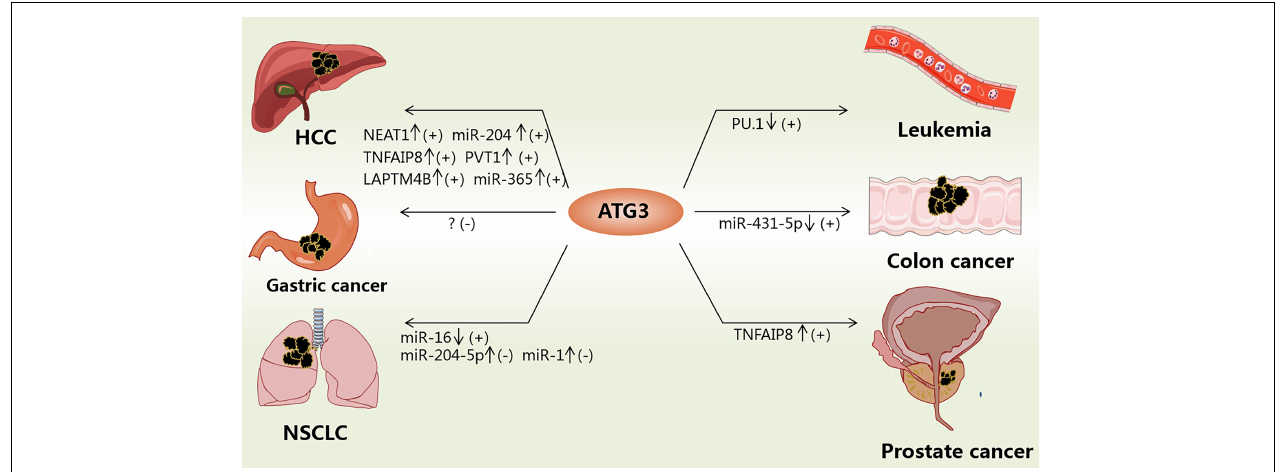
FIGURE 2 | Functions of ATG3 in cancers. ATG3 could be modulated by different factors in cancers. “ ↓ ” means the corresponding factor is downregulated; “ ↑ ” means the corresponding factor is upregulated; “+” means inducing cancers; “-” means suppressing